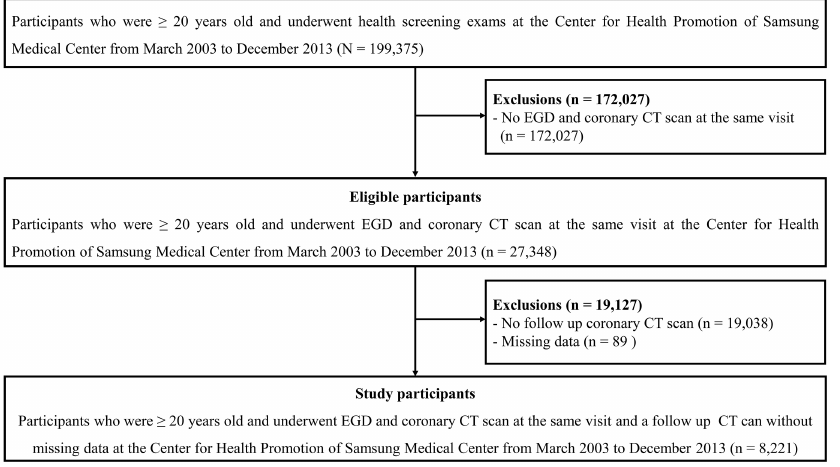
Fig 1. Study flow chart. EGD, esophagogastroduodenoscopy; CT, computedtomography.